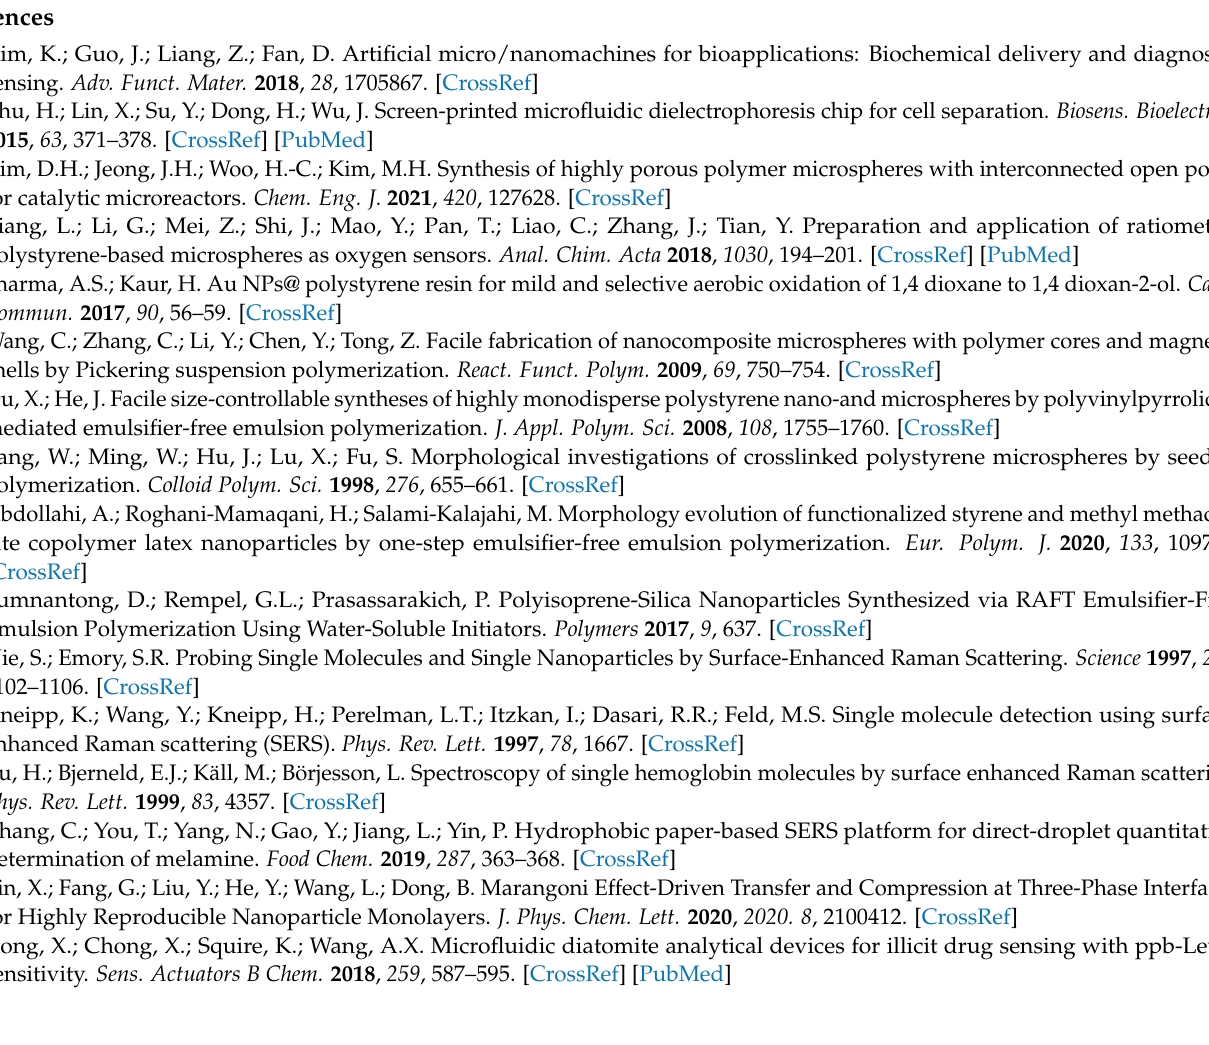
SEM images of colloidal PS/Ag with different volume of PS colloid,400 uL (a), 100 uL (b), 50 uL (c), Figure S3: Raman spectra of MBA (100 ppm) on colloidal PS/Ag composites with different volumes of PS colloid, Figure S4: UV-vis spectra of different concentrations of DMZ(a), and the linear relationship between concentration and absorbance (b), Figure S5: UV-vis spectra of DMZ (100 ppm) from real pork sample after 100-fold dilution, Figure S6: Raman spectra of different concentrations of DMZ from pork after washing with